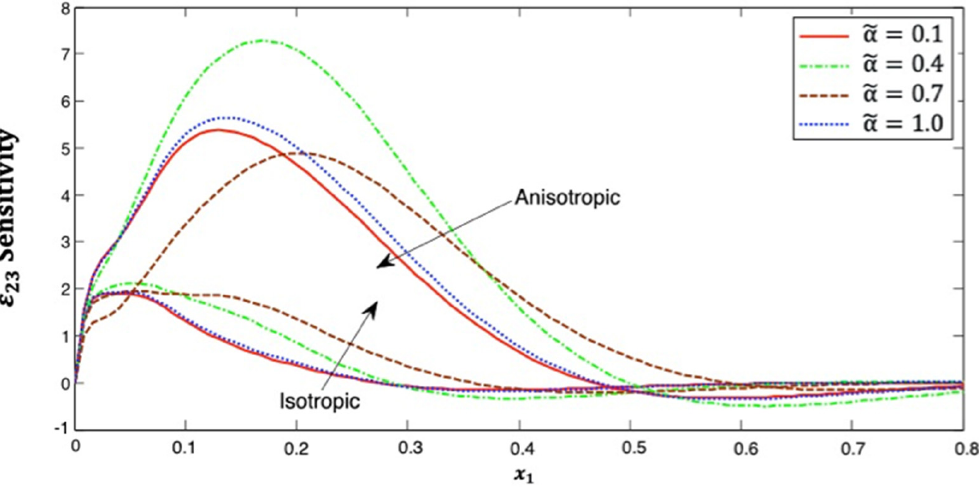
Figure 12. Distribution of the ε 23 sensitivity along x 1 –axis in isotropic and anisotropic FRP composites for various fractional-order values.